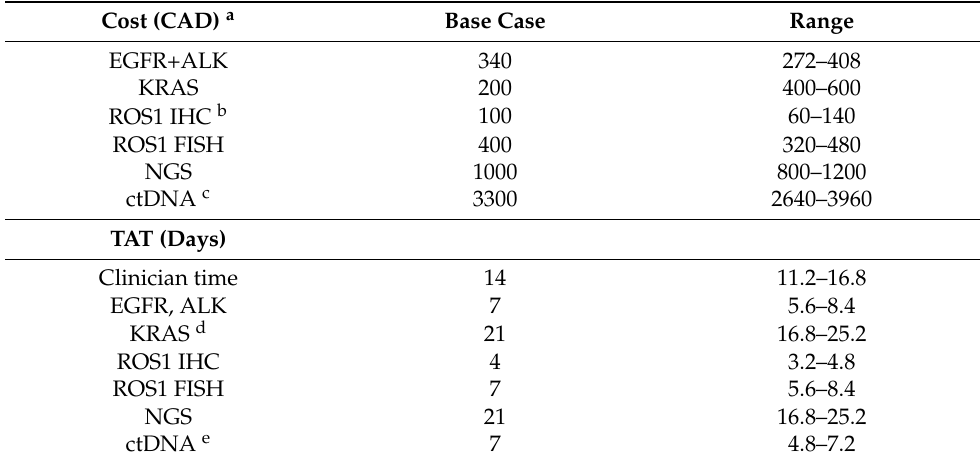
Table 1. Diagnostic test costs and turnaround time